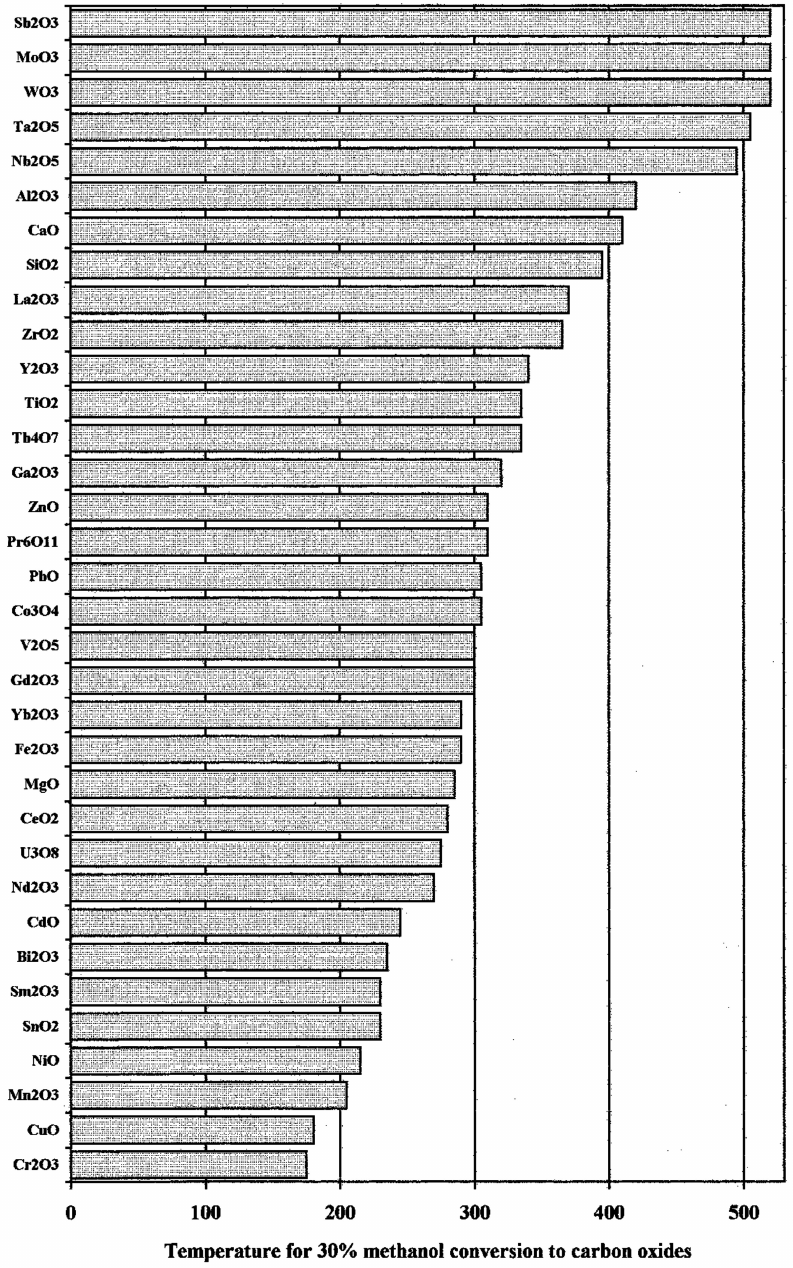
Figure 43. MeOH stability based on the temperature at which 30% conversion of the fed MeOH was converted to carbon oxides. MeOH/O 2 /He = 1/4/12, 12000 h − 1 . Reprinted from [228] Copyright © (1999), with permision from